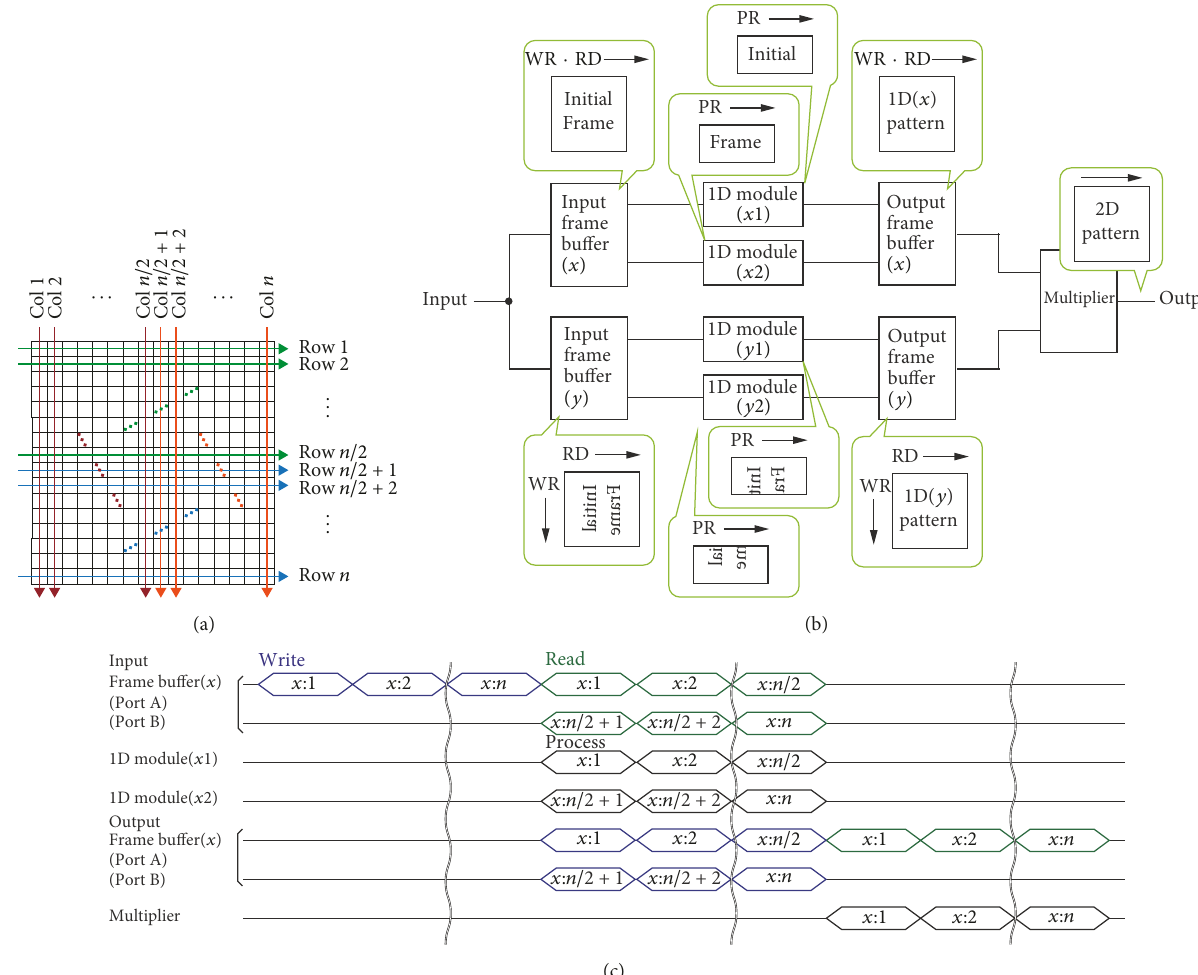
Figure 3: Protoarchitecture and operation of the two-dimensional RD system. (a) Independent row and column processing in a one- dimensional algorithm. (b) Block-level system protoarchitecture. (c) Detailed timing